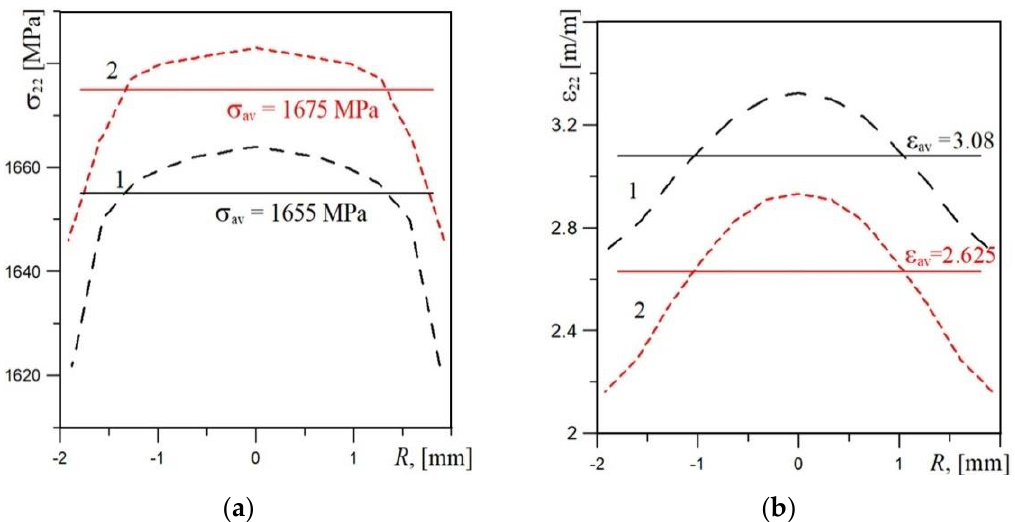
Figure 8. The stress ( a ) and strain ( b ) distributions obtained by numerical calculation (uniaxial tensile test specimen) for the X52 steel in the as-received state (1) and after 30 years of service (2), where σ 22 —stress in the tensile direction, ε 22 —strain in the tensile direction, σ av —the mean value of stress σ 22 , ε av —the mean value of strain ε 22 , R —the distance from specimen axis.